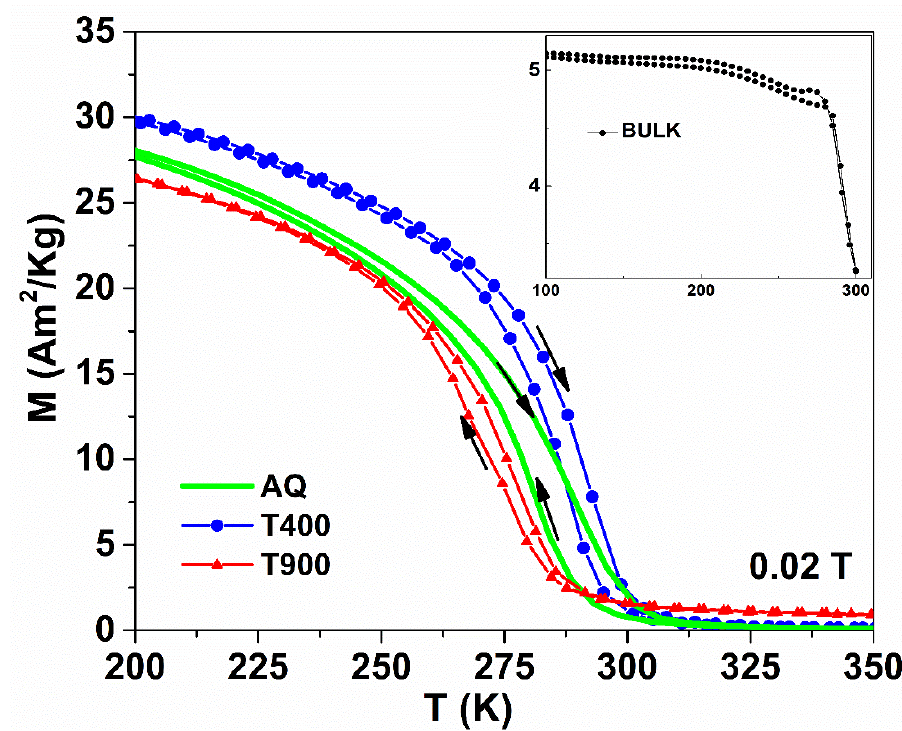
Figure 4. Temperature dependence of magnetization for AQ, T400 and T900 ribbons and for Bulk in inset.